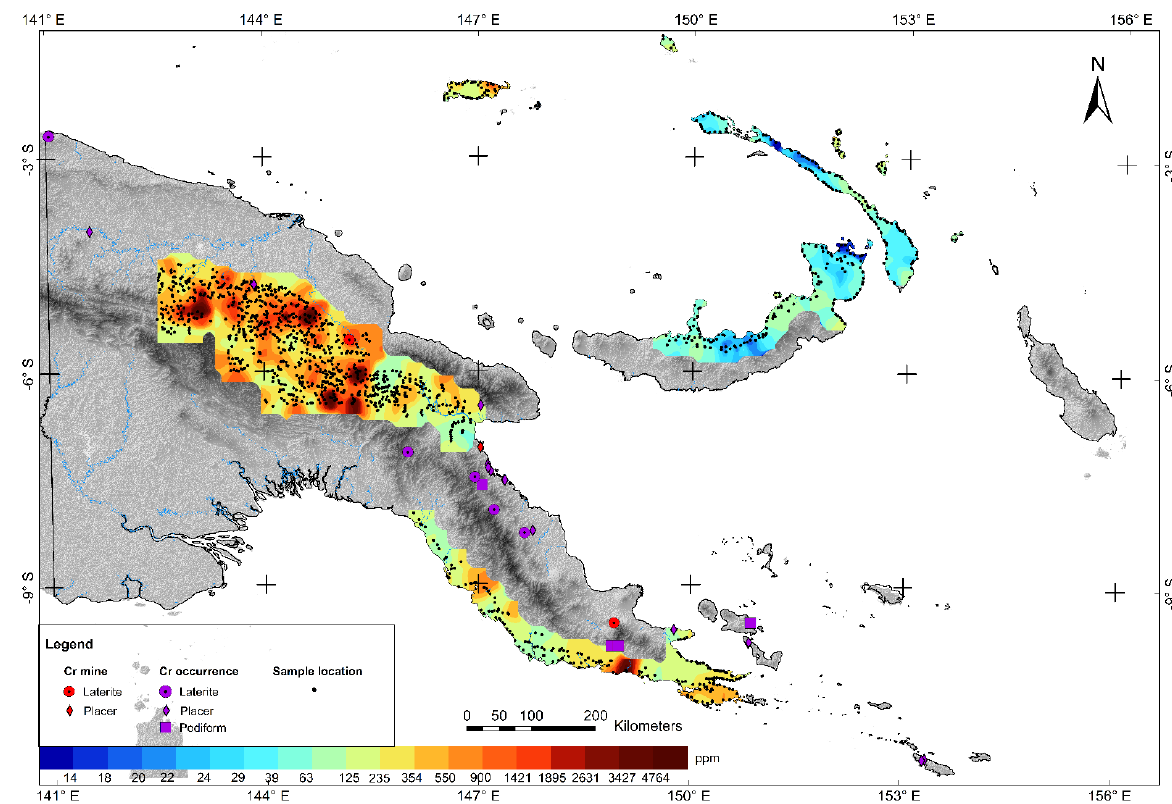
Figure 2. Chromium geochemical contour map of PNG.